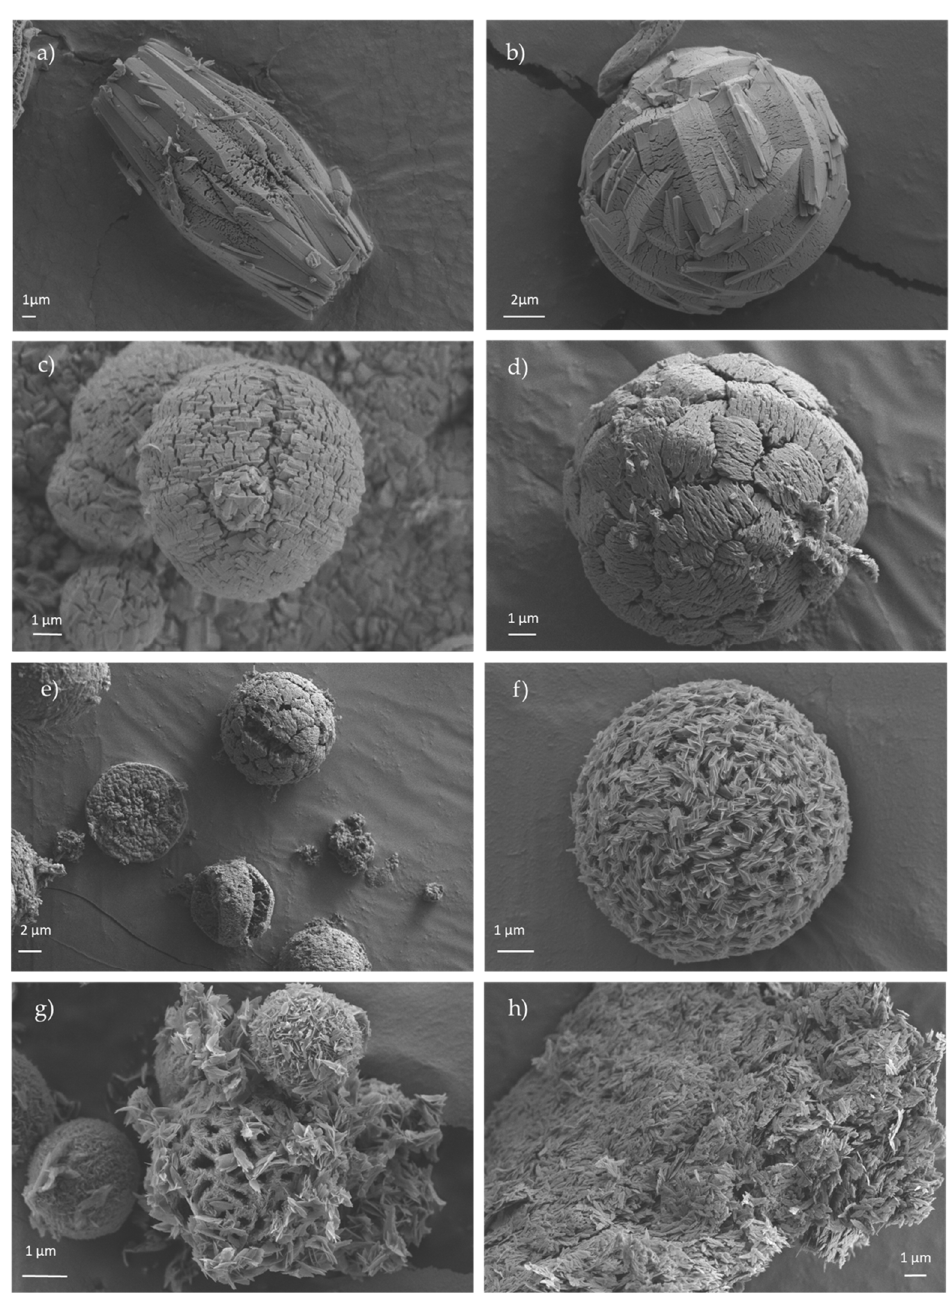
Figure 5. FESEM micrographs of the synthesized materials: ( a ) CIM-80_2; ( b ) CIM-80_4; ( c ) CIM-80_6; ( d ) CIM-80_7.5; ( e ) CIM-80_8.5; ( f ) CIM-80_10; ( g ) CIM-80_10_CTAB; ( h ) AlO(OH).